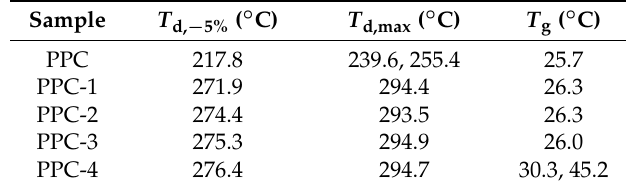
Table 2. The thermal properties of PPC and PPC with networks.